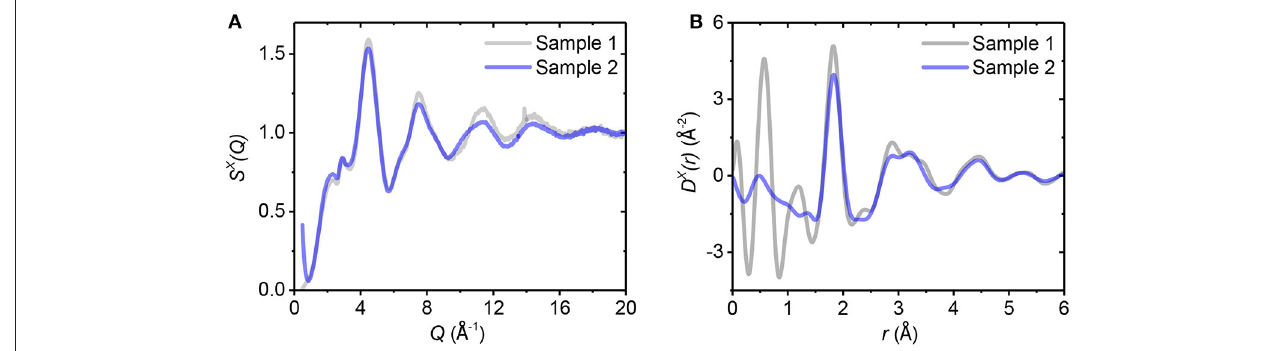
FIGURE 5 | The (A) x-ray total structure factor S(Q) and (B) total differential distribution function D(r) for two amorphous alumina samples.